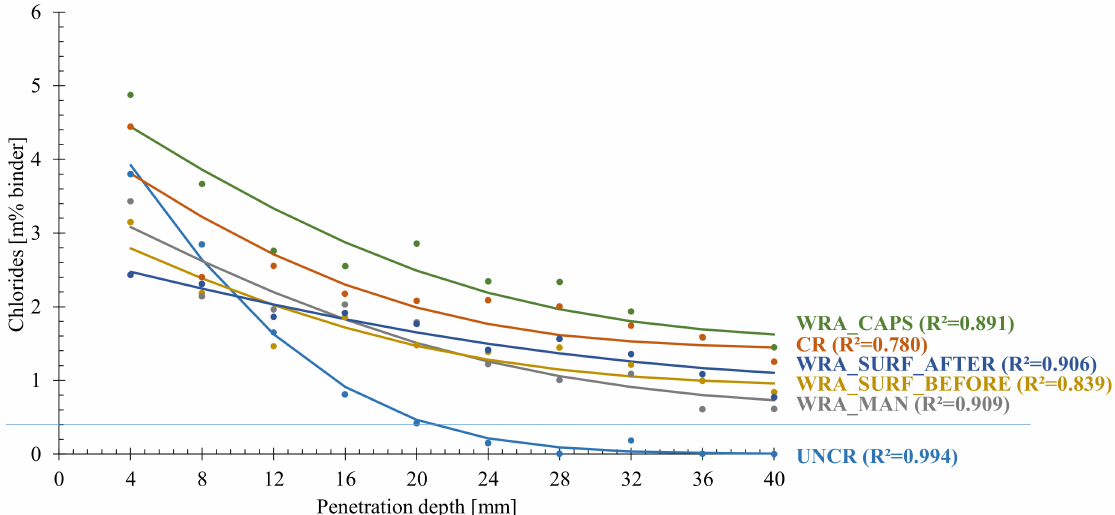
Figure 10. Chloride ingress values and fitted profiles (with Fick’s second law of diffusion) obtained after titration of the ground